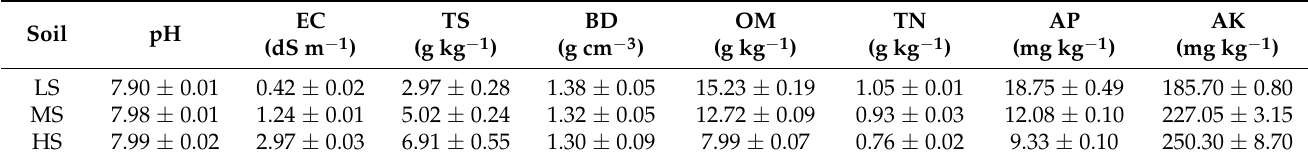
Table 1. Properties of light-salinity soil (LS), medium-salinity soil (MS), and heavy-salinity soil (HS).